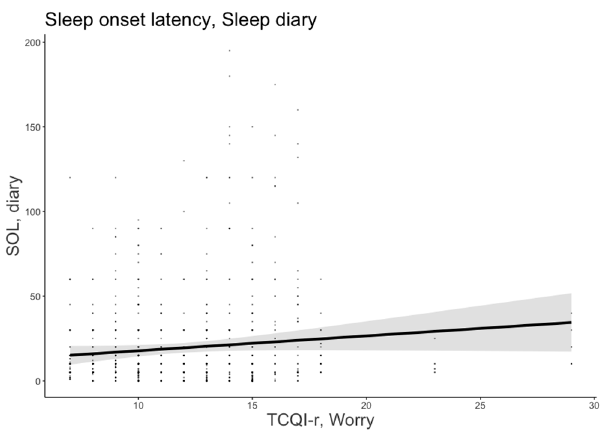
Figure 2. Subjective sleep onset latency as a function of worry strategy. The error bars represent 95% confidence intervals of the estimated means.